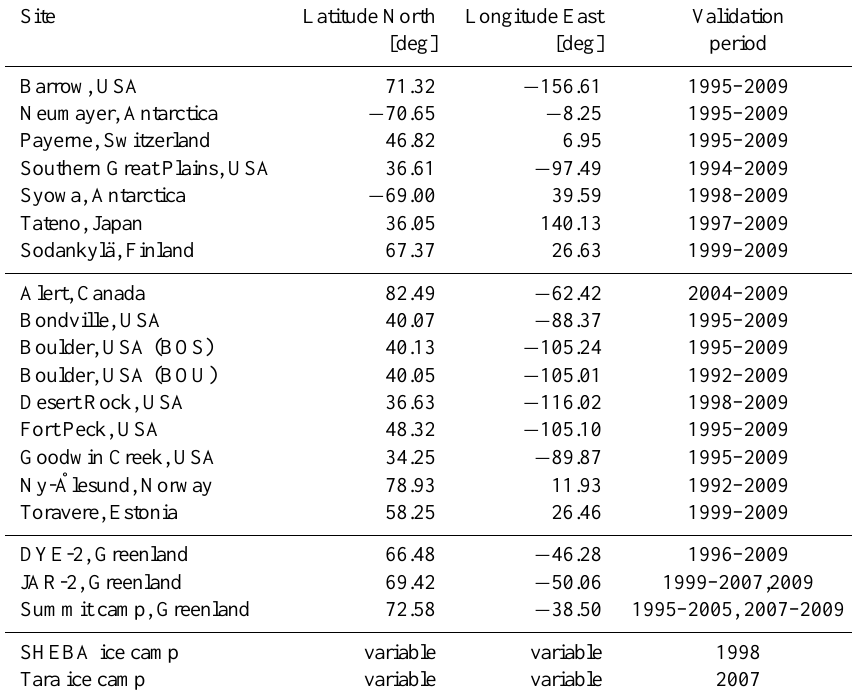
Table 2. The validation sites used in this study. Sites listed with in the 2nd and 4th block use an alternative method for formulation of the site’s temporal mean albedo. See text for